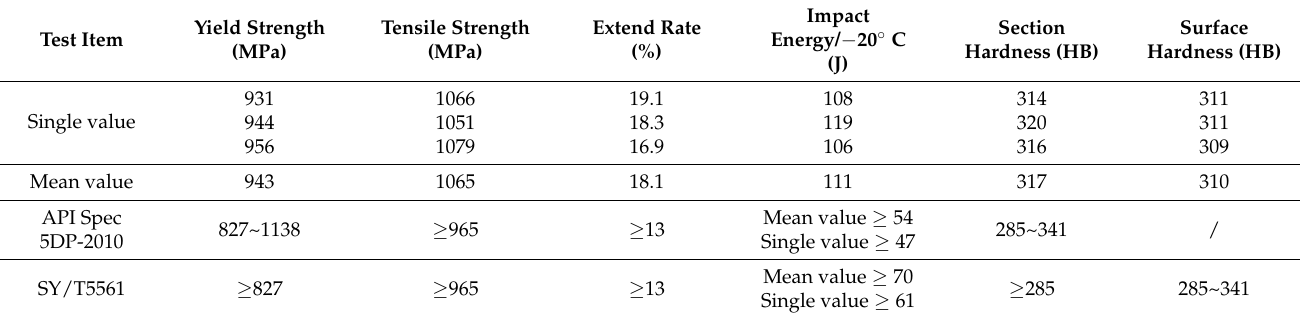
Figure 7. Tensile results of drill pipe specimens. Table 2. Mechanical properties of drill pipe joint.